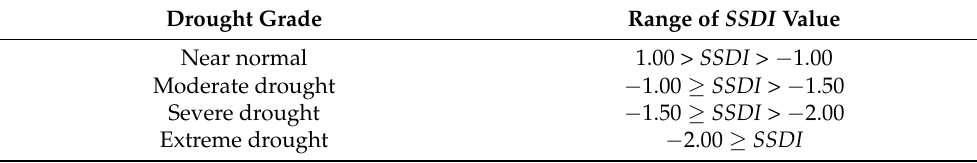
Table 1. Classification of SSDI (standardized supply-demand water index) and drought grade.